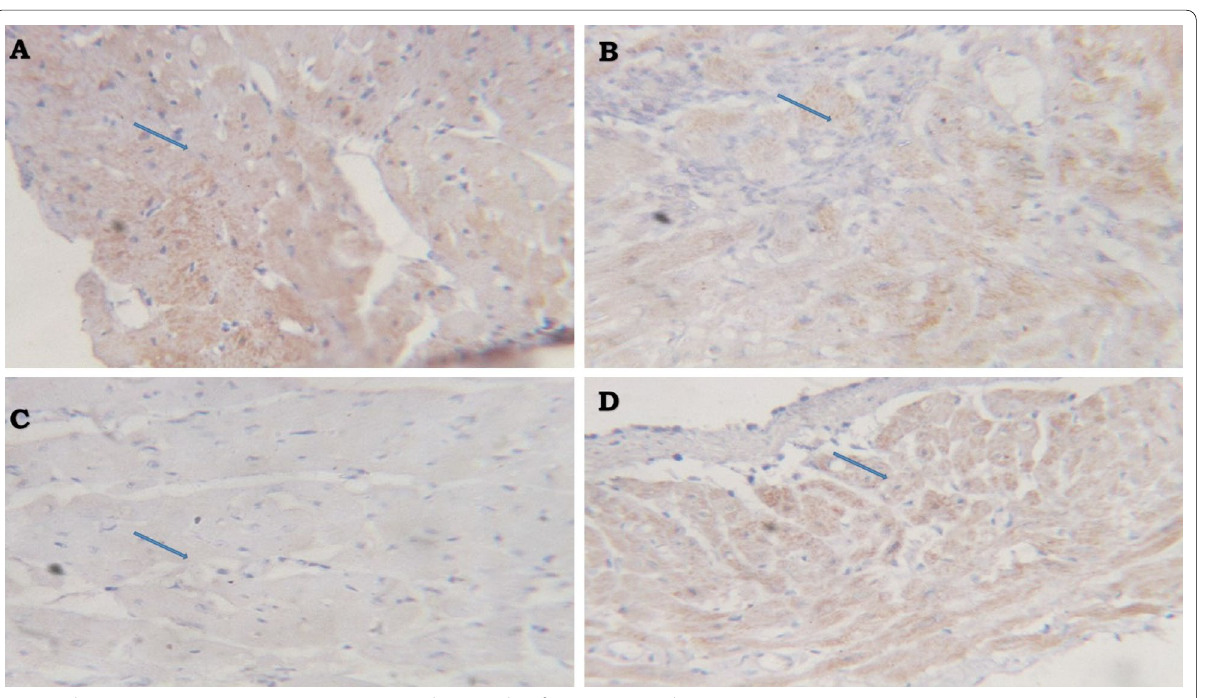
400). A Represents ×